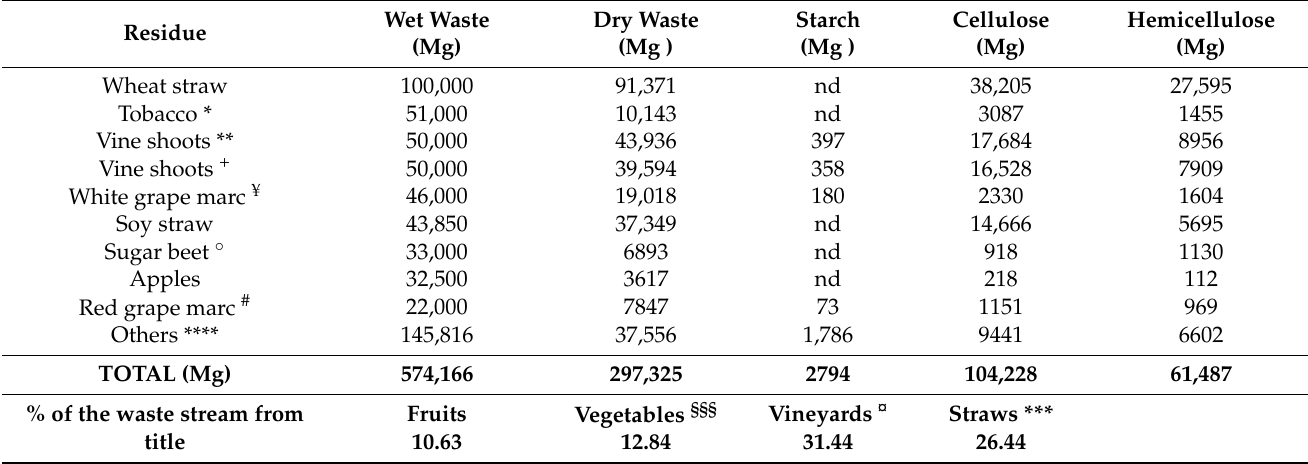
Table 2. Expected amounts (wet and dry) of residues from crops grown in the analyzed area and producing high amounts of wastes. Results of chemical analyses are the means of three replicates. Amounts of agricultural residues and main polysaccharides on a dry matter basis were estimated based on the information obtained from the farmers and the performed chemical analyses,